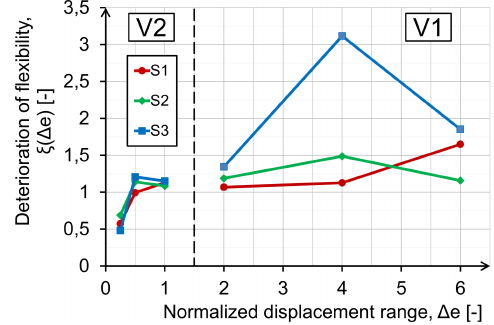
Figure 13: Deterioration of flexibility ξ ( ∆e ) versus relative displace- ment ∆e , evaluated from V1 and V2 loading histories at the load factor 𝛾 1 = 1.0.